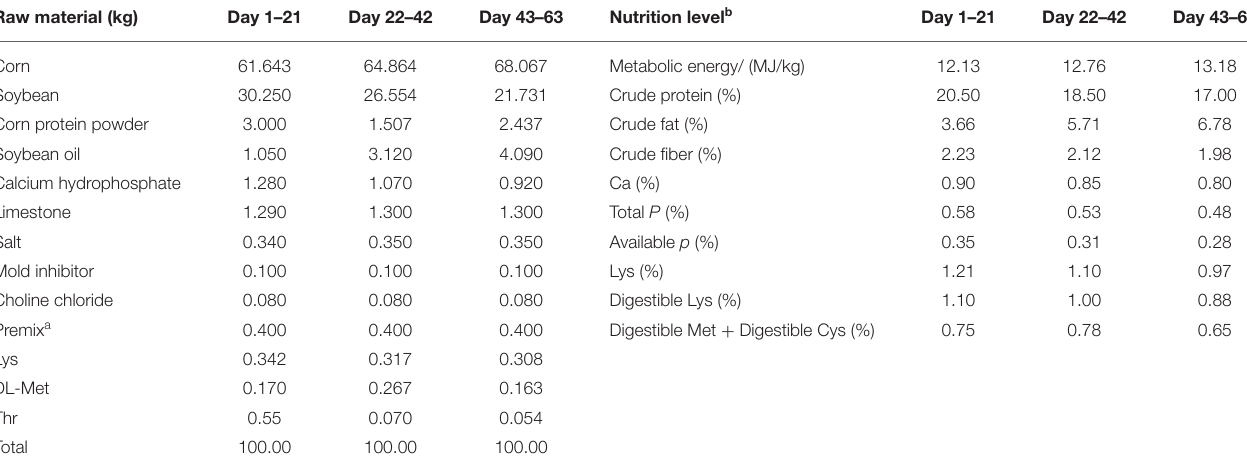
TABLE 2 | The composition and nutrition level of basal diet (air-dry basis). Raw material